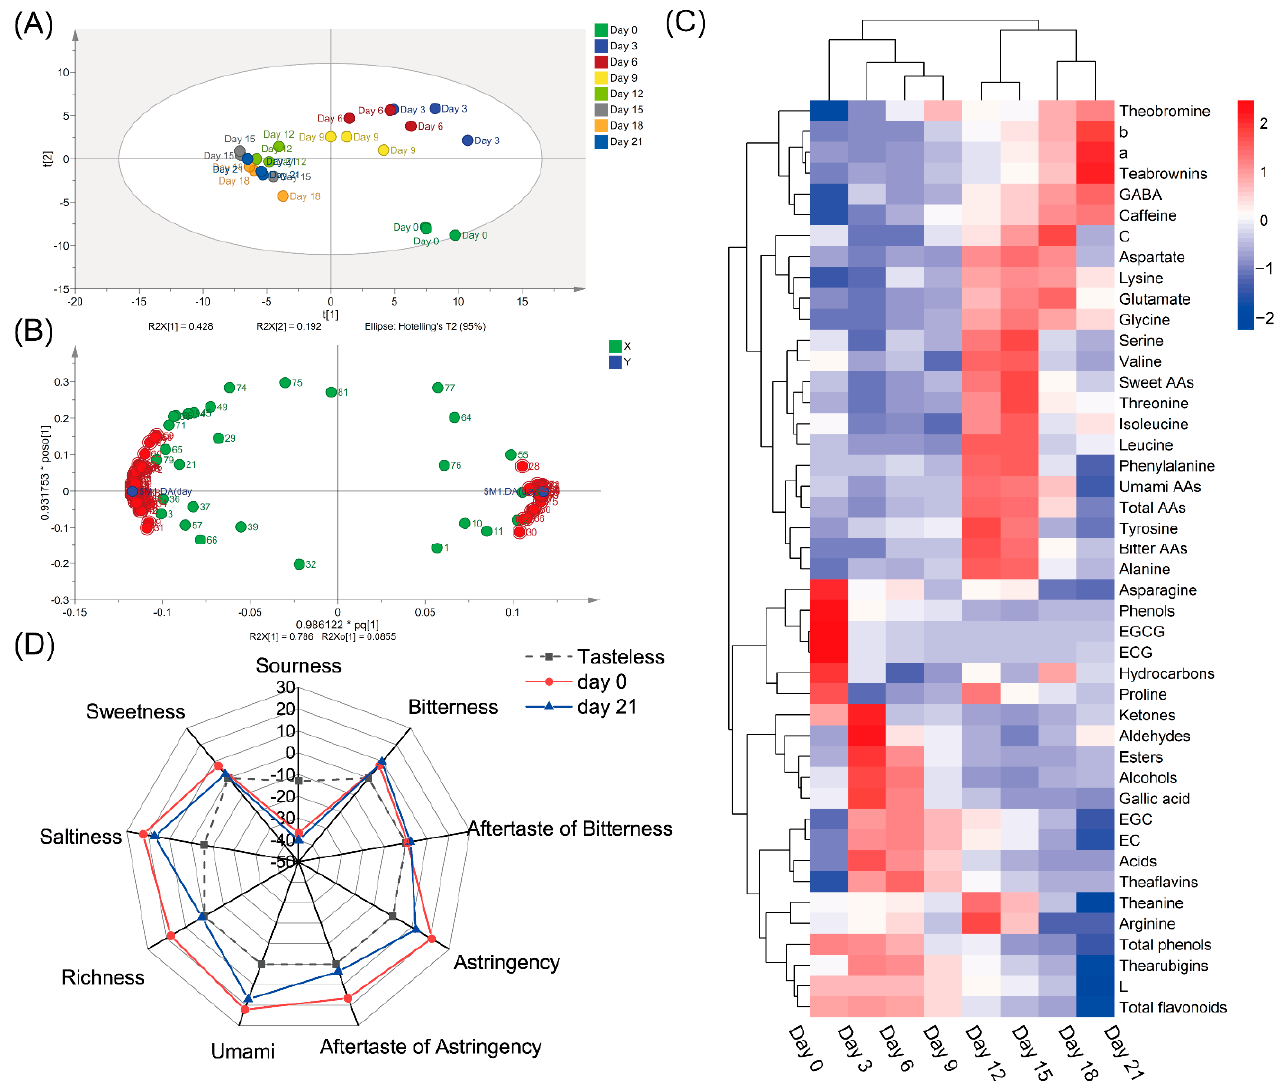
Figure 4. The analysis of taste characteristics and the dynamics changes of metabolites in tea samples during fermentation. ( A ) Score scatter plot of PLS-DA analysis based on all metabolites detected in all fermented samples. ( B ) Loading scatter plot of OPLA-DA analysis based on all metabolites detected in samples on Day 0 and Day 21. ( C ) Results of heatmap analysis. ( D ) The taste scores of samples on Day 0 and Day 21. GABA, γ -aminobutyric acid; AAs, amino acids.